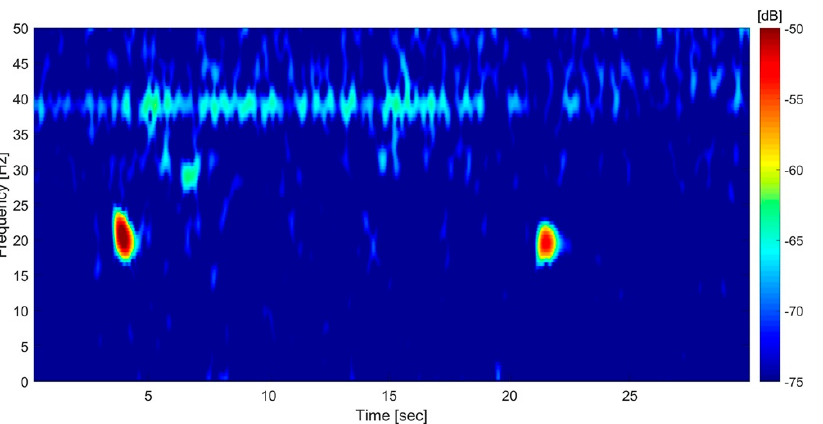
Figure 1. Spectrogram created in MATLAB showing two fin whale vocalizations recorded by EAR3 on 22 October, 2011. The spectrogram was produced at 2048 points FFT (fast Fourier transform), 4096-point Hann window, and 1000 overlap points.